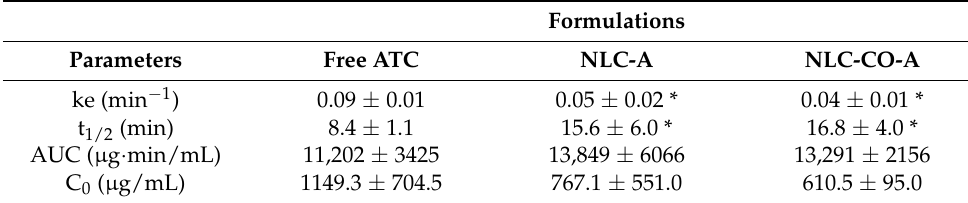
Table 4. Pharmacokinetic parameters obtained by tissue microdialysis using free and encapsulated articaine formulations: in synthetic NLC (NLC-A) or natural NLC